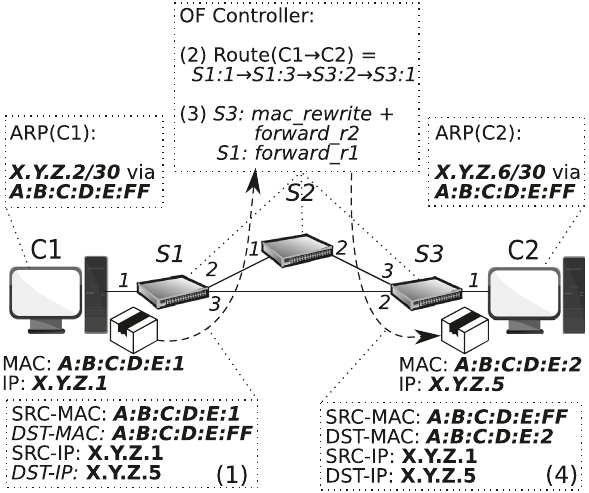
Figure 9: IP switching (a.k.a. routing) with virtual MAC addresses.